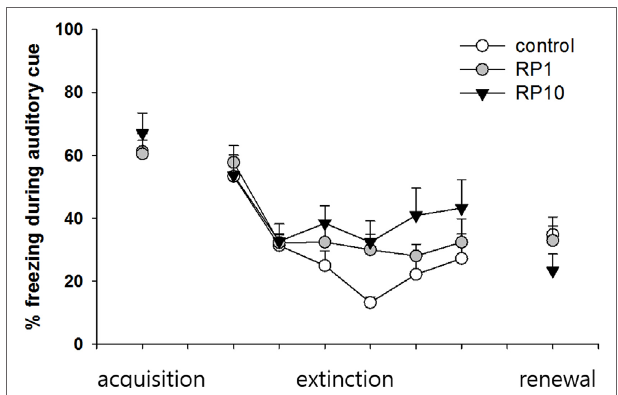
FigUre 5 | The effect of Radix Polygalae (RP) on cued fear memory acquisition, extinction and renewal. The average % freezing of eight sessions (acquisition) or five sessions (extinction and renewal) are plotted. Repeat measure analysis of variance (ANOVA) showed within-group (procedure) effect [ F (3.5, 94.3) = 17.3, p < 0.001, η 2 = 0.391] but non-significant between-group (treatment) effect [ F (2,27) = 0.73, p = 0.49, η 2 = 0.052] and within–between interaction [ F (7.0, 94.3) = 2.0, p = 0.06, η 2 = 0.13]. In the control group, fear reduced during the extinction training (first extinction training block vs. sixth extinction training block; p = 0.048), but fear did not increase during the renewal procedure. In both RP1 and RP10, fear extinction and fear renewal were not significant (fear extinction in RP1; p = 0.062). Data represent mean ± SEM. control: DW; RP1: Radix Polygalae 1 mg/kg p.o. 10 days; RP10: Radix Polygalae 10 mg/kg p.o. 10